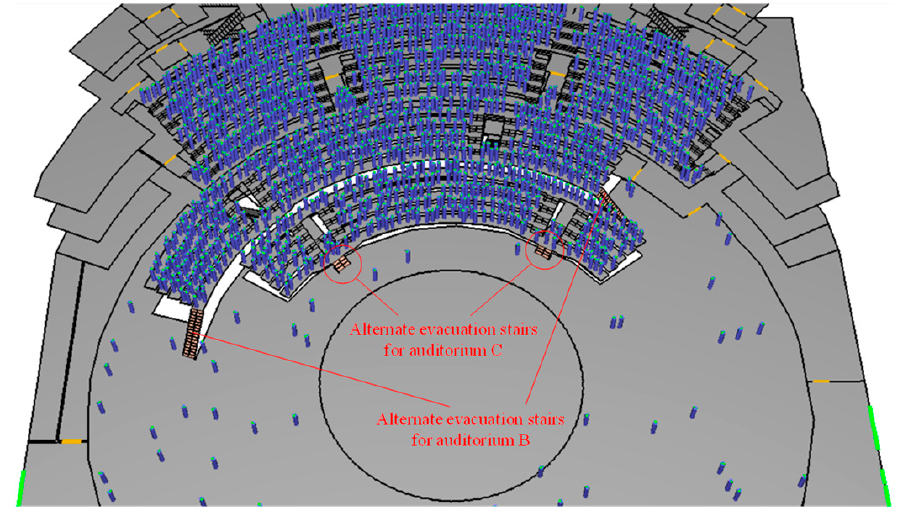
Figure 20. Location of the alternate evacuation stairs for auditorium B and auditorium C.